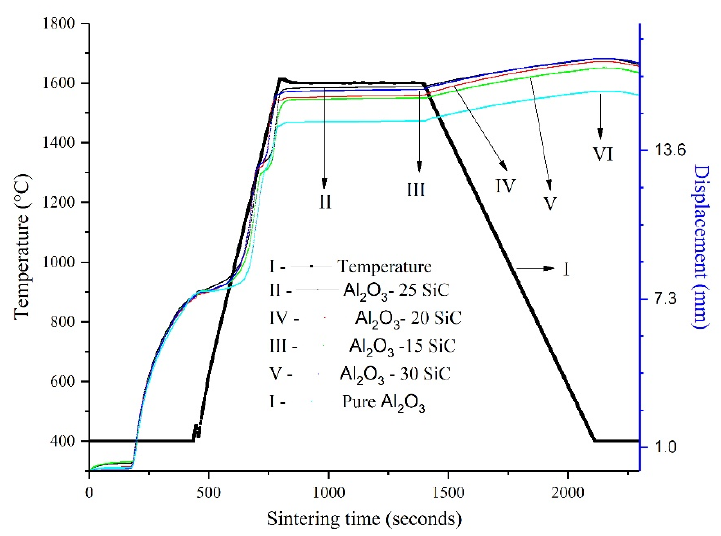
Figure 4. Shrinkage response of pure Al 2 O 3 and Al 2 O 3 –SiC composites during spark plasma sintering.